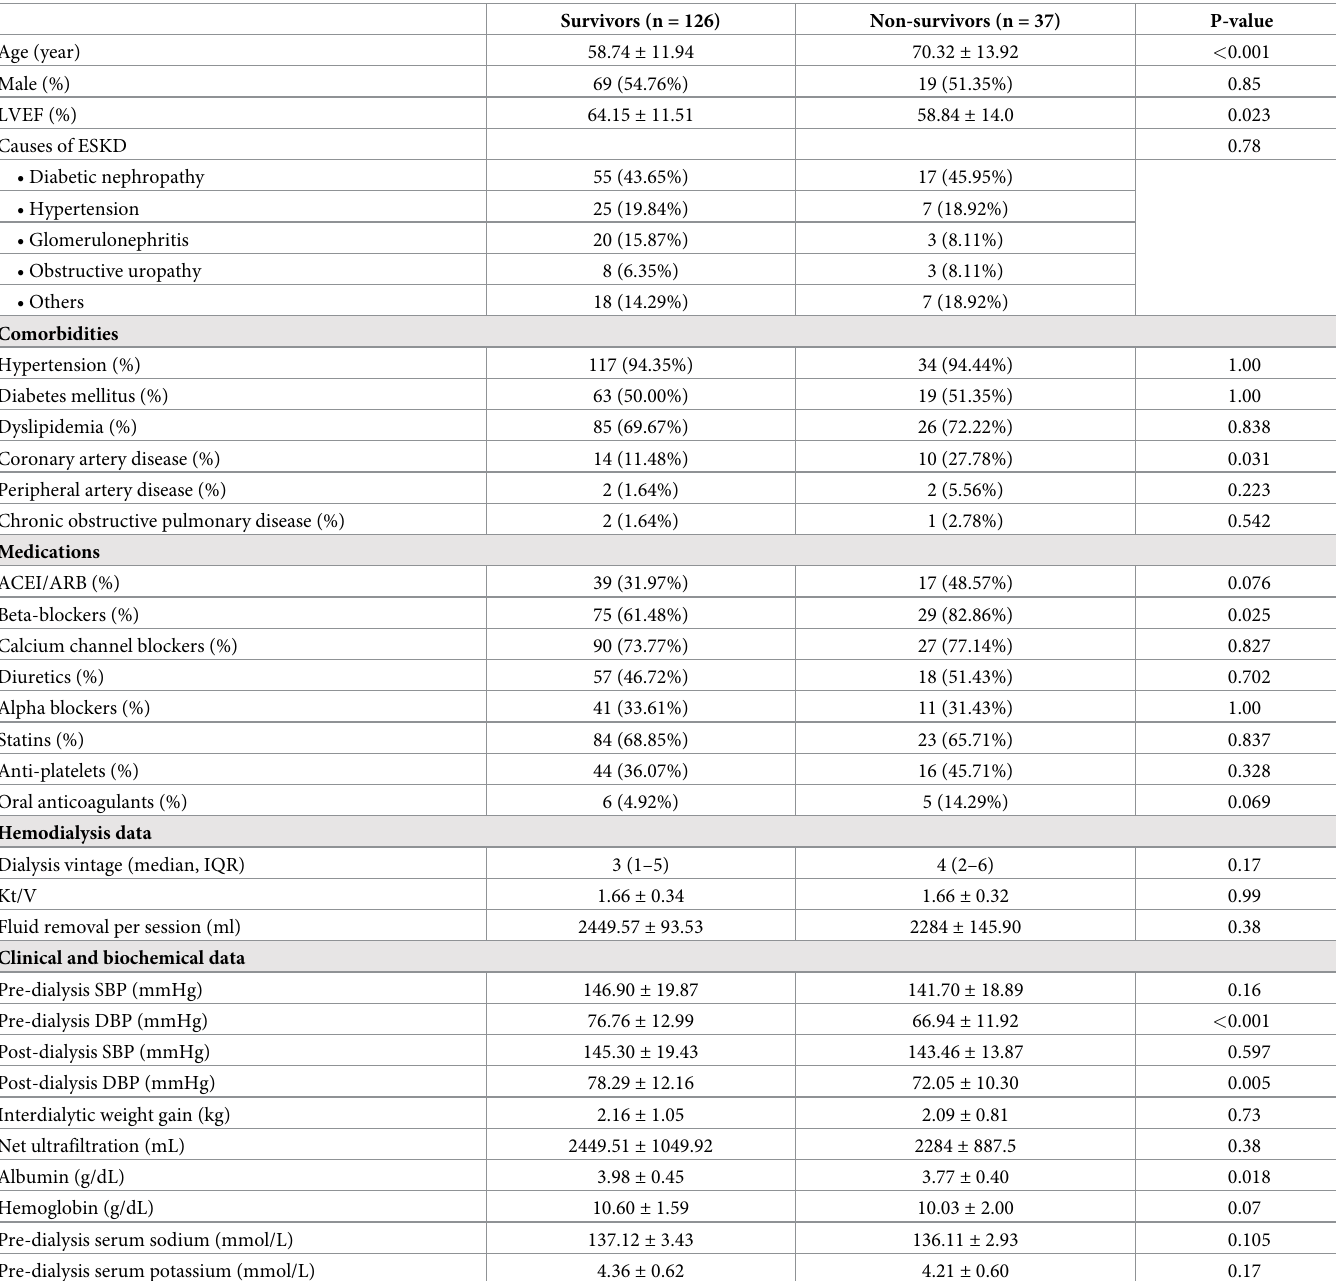
Table 1. Baseline characteristics between survivors and